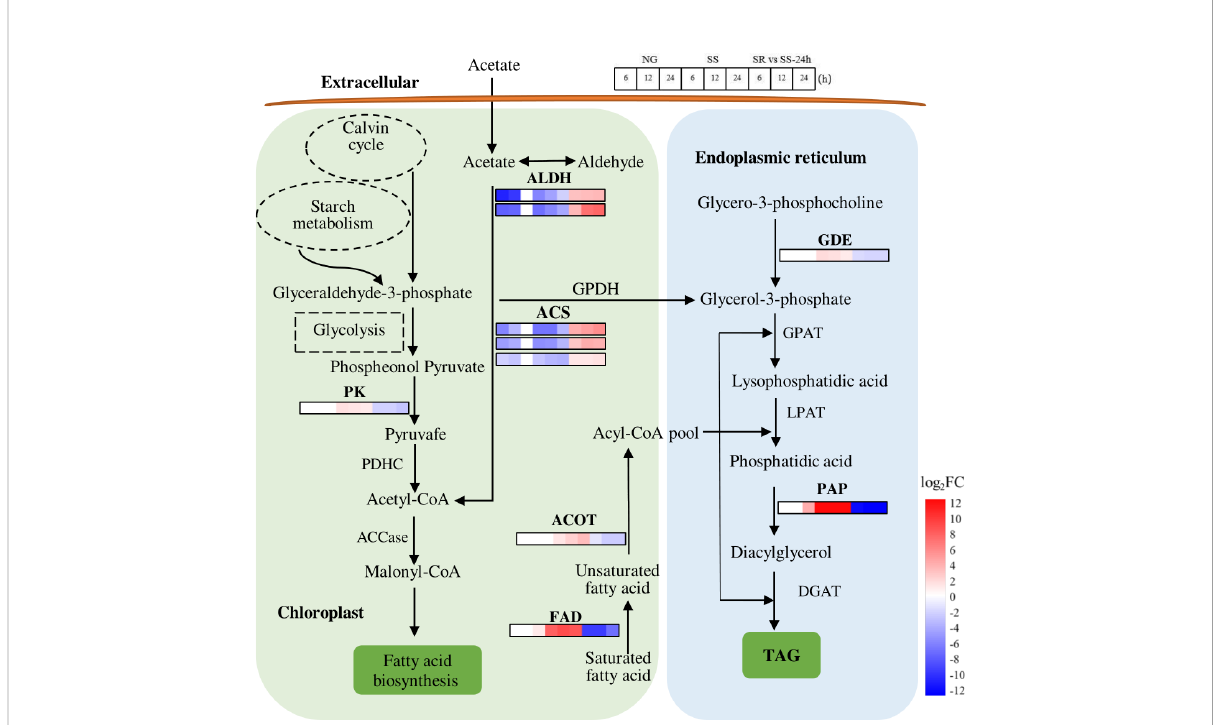
FIGURE 8 Expression patterns of identi fi ed SRV-DEGs in lipid synthesis pathway of C. sorokiniana. ALDH, aldehyde dehydrogenase; ACS, acetyl-CoA synthetase; PK, pyruvate kinase; PDHC, pyruvate dehydrogenase; ACCase, acetyl-CoA carboxylase; FAD, fatty acid desaturase; ACOT, acyl- coenzyme A thioesterase; GPDH, glycerol-3-phosphate dehydrogenase; GDE, glycerophosphodiester phosphodiesterase; GPAT, glycerol-3- phosphate acyltransferase; LPAT, lysophosphatidic acid acyltransferase; PAP, phosphatidic acid phosphatase; DGAT, diacylglycerol acyltransferase. Color legends are shown at the bottom right of the map. The time points of the genes ’ expression pattern are shown at the top right of the